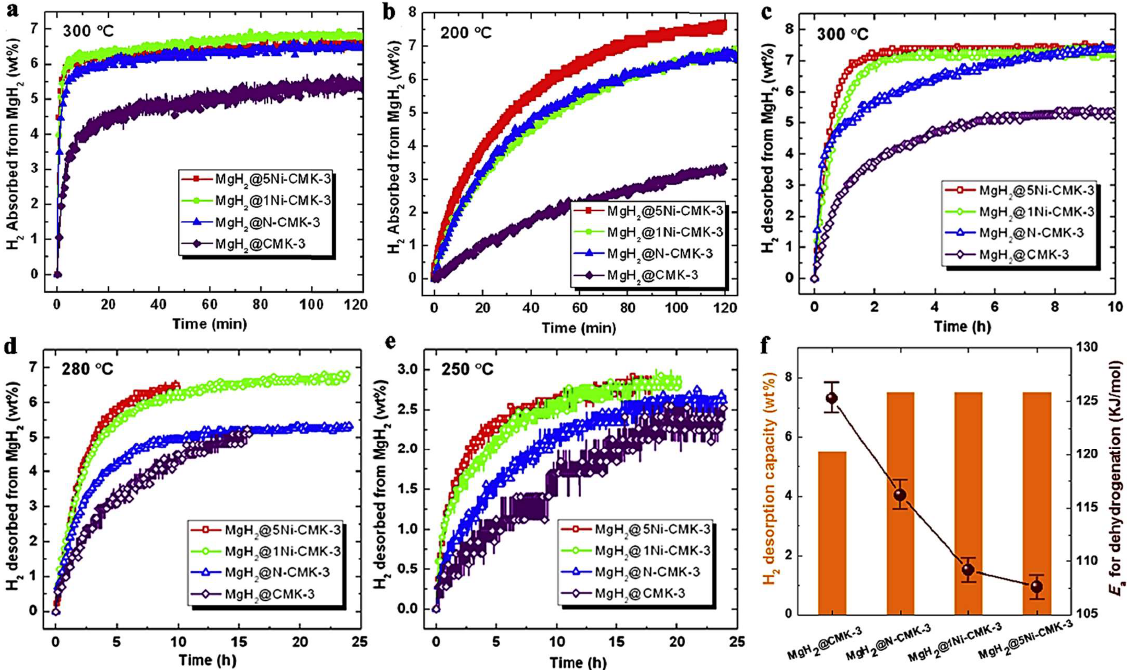
Figure 6. Hydrogenation kinetics of MgH 2 @CMK-3, MgH 2 @N-CMK-3 and MgH 2 @xNi-CMK-3 (x = 1 and 5) at 300 °C ( a ) and 200 °C ( b ) and under 19.74 atm. H 2 backpressure. Hydrogen desorption profiles of the four investigated samples at 300 °C ( c ), 280 °C ( d ), 250 °C (vacuum, p < 0.01 atm) ( e ). Dehydrogenation of nanocomposites within two hours at 300 °C and corresponding desorption ac- tivation energies. E a,des ( f ) . Reprinted/adapted with permission from Ref. [92]. 2017, Elsevier. The enhancement in kinetics was obvious; van’t Hoff plot analysis revealed system-